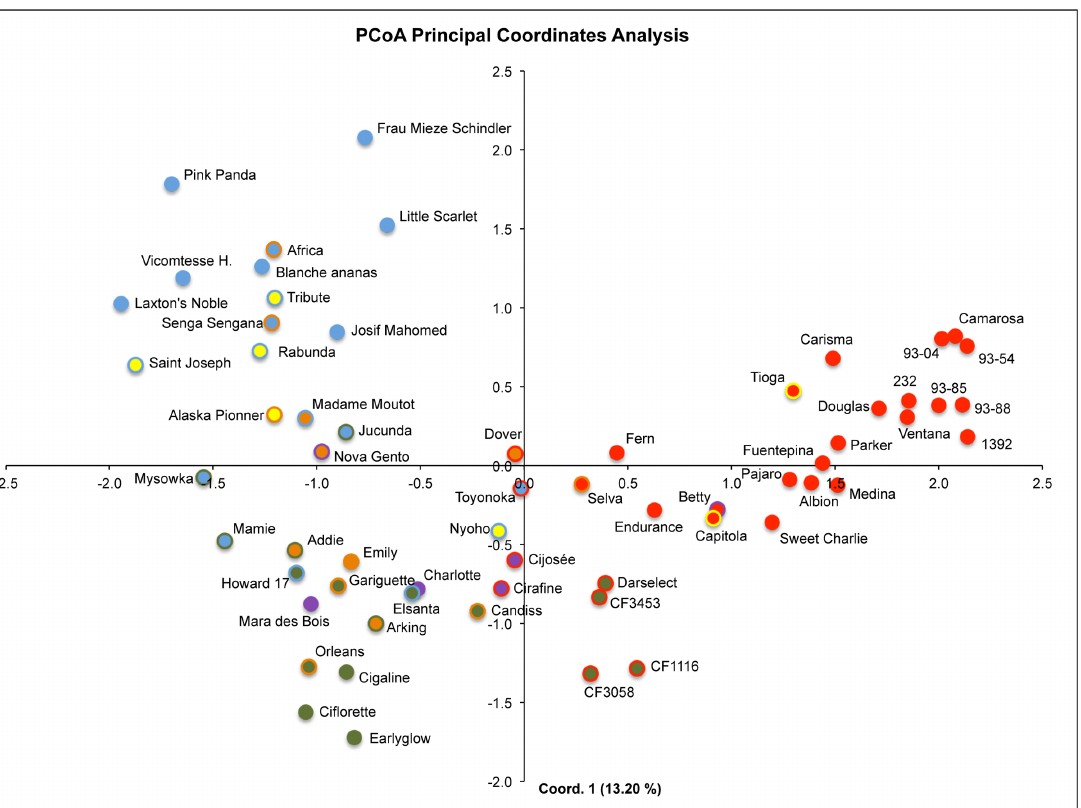
Fig 2. Principal coordinates analysis (PCoA) of 62 strawberry accessions based on 603 DArT markers. Accessions were labeled according to the STUCTURE results colors. Cultivars with admixed ancestry were labeled with the 2 most representing colors. The x axis represents the eigenvalue for principal coordinate 1 (PCo1) and the y axis for PCo2. The percentages of genetic diversity explained by the first and the second component were 13.20 and 6.06, respectively.